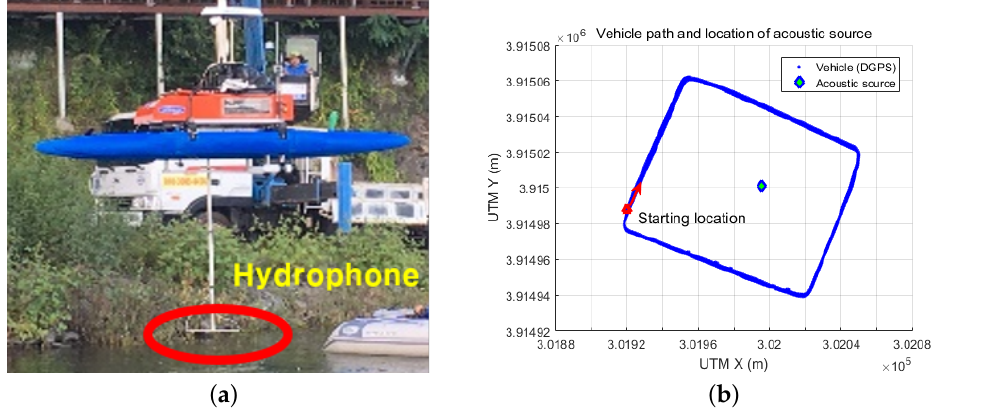
Figure 4. Experimental setup: ( a ) USV equipped with two hydrophones; and ( b ) vehicle path and location of acoustic source acquired from DGPS.